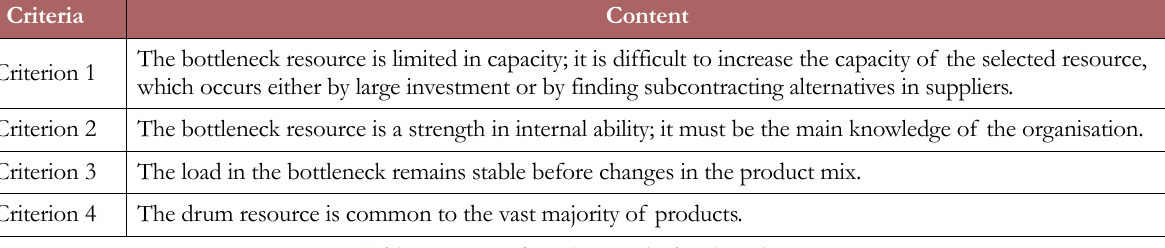
Table 6. Criteria for selecting the